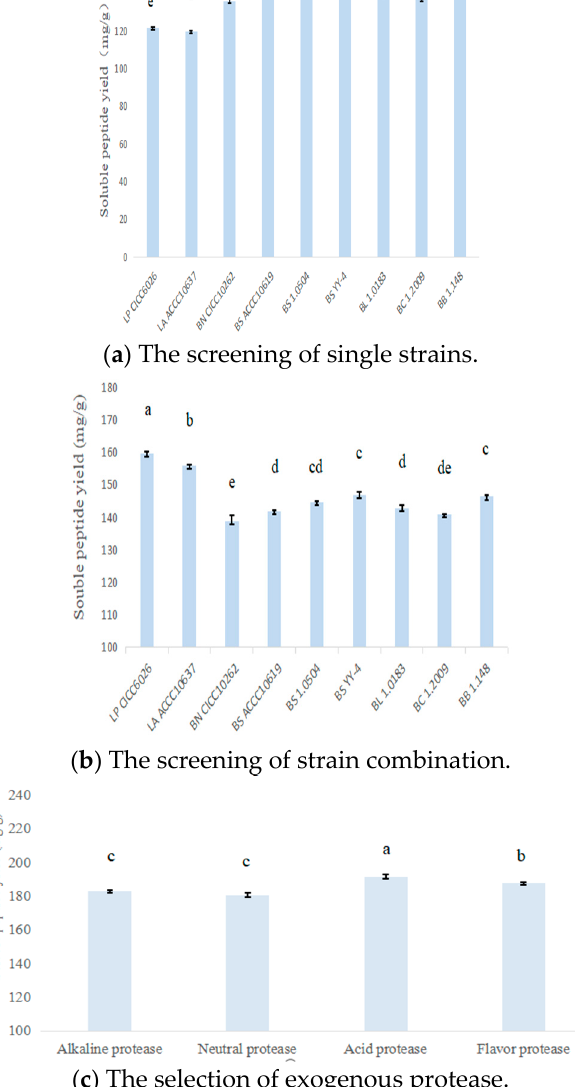
Figure 3. Screening of strain, strain combination and exogenous protease. Note: a–f, different lowercase superscripts indicate significant differences ( p < 0.05) in the same row.